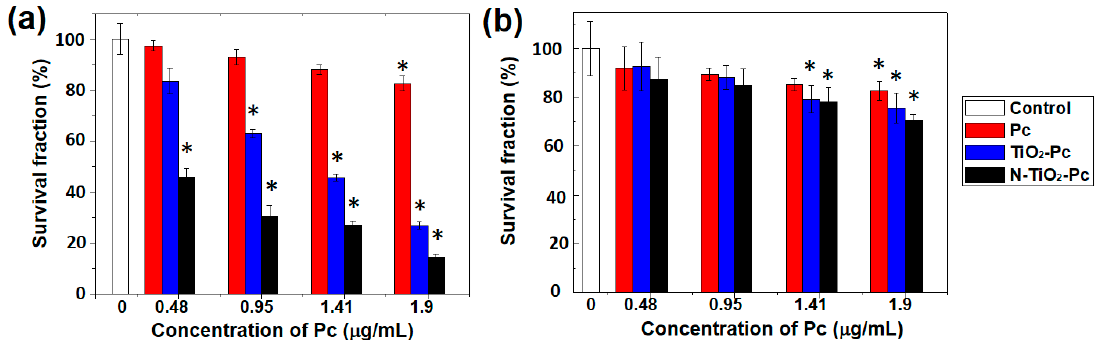
Figure 3. The photokilling effect on HeLa cells treated with 5.5–21.9 μ g·mL − 1 N-TiO 2 -Pc or TiO 2 -Pc with ( a ) 420–800 nm; ( b ) 420–575 nm light irradiation. For comparison, cells incubated with the same amount of 0.48–1.9 μ g·mL − 1 Pc were studied as well. * represents significant difference from the control group ( p < 0.05).